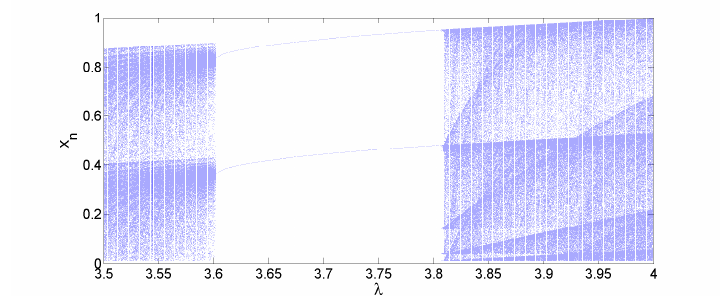
Fig. 5 Bifurcation diagram of (2) with respect to λ where x b = 0 . 48, λ ∗ = 0 .